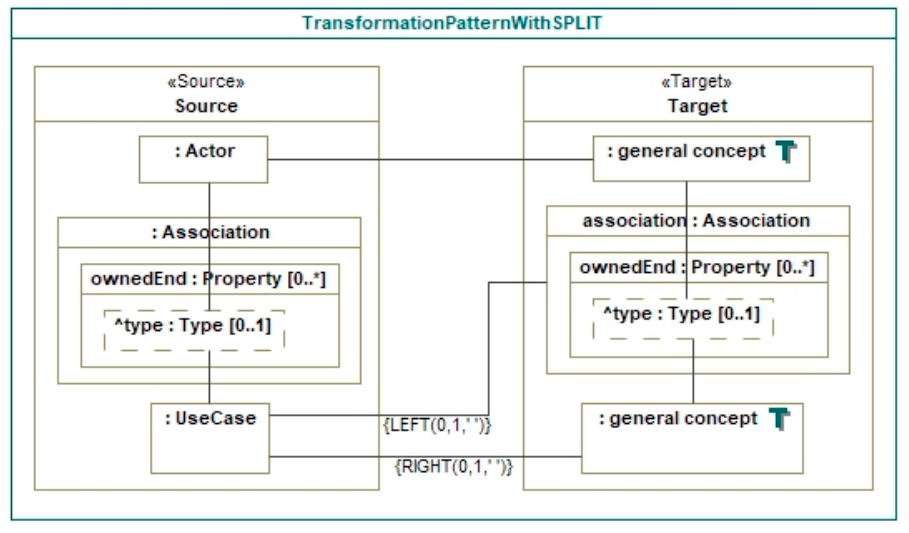
Figure 6. Sample transformation pattern with SPLIT.